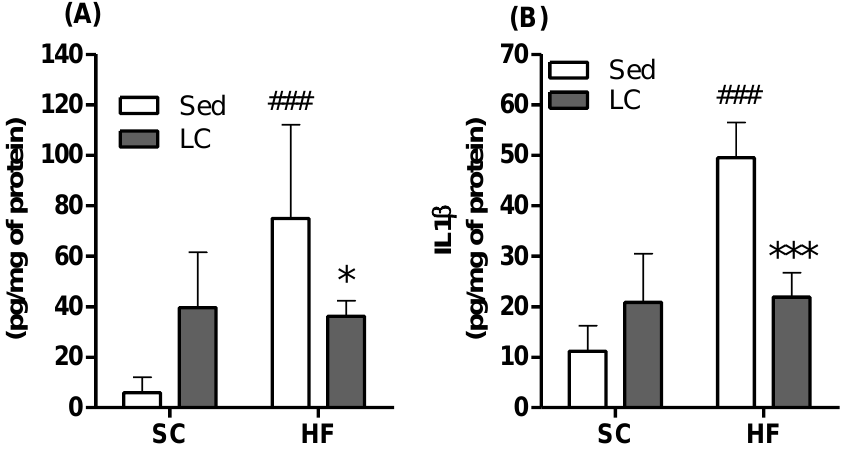
membrane subunit p22 phox (2.93-fold) (Figure 7E) in animals fed the SC. A high-fat diet (HF Sed ) significantly increased the relative mRNA expression of all subunits evaluated when compared to the SC Sed group (gp91 phox : 8.14-fold; NOX4: 5.30-fold; p47 phox : 4.69-fold; p67 phox : 3.77-fold; p22 phox : 2,72-fold) (Figure 7A–E). HF LC was only able to significantly decrease the expression of the gp91 phox subunit compared to HF Sed (3.24-fold) (Figure 7A).